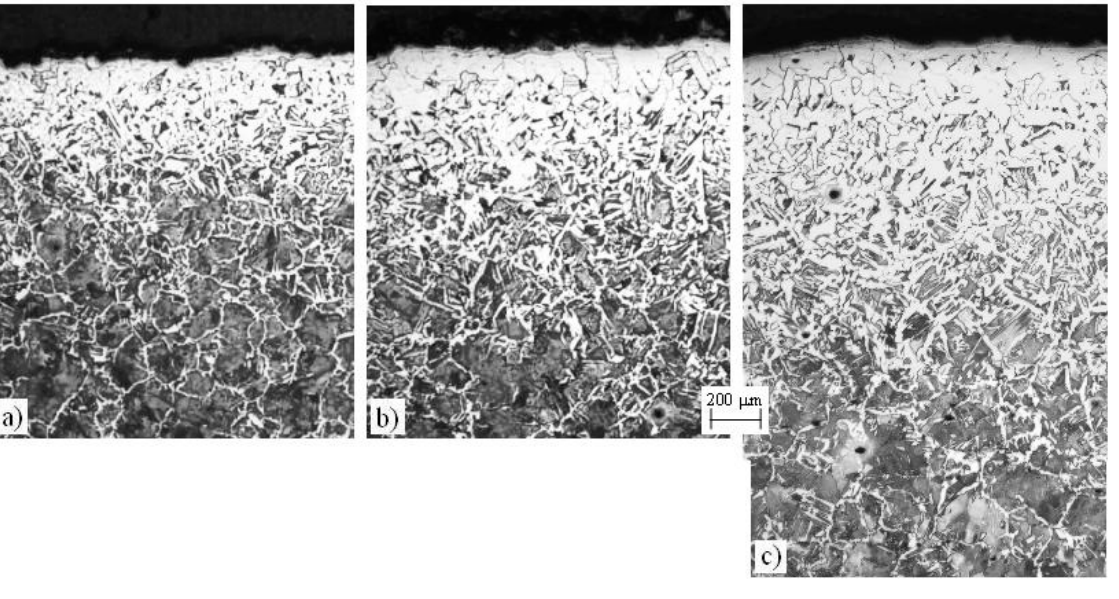
Figure 9. Microstructure of the surface part of C45 steel after annealing at T a = 1100 °C. ( a ) t a = ½ h, ( b ) t a = 1 h, ( c ) t a = 2 h.